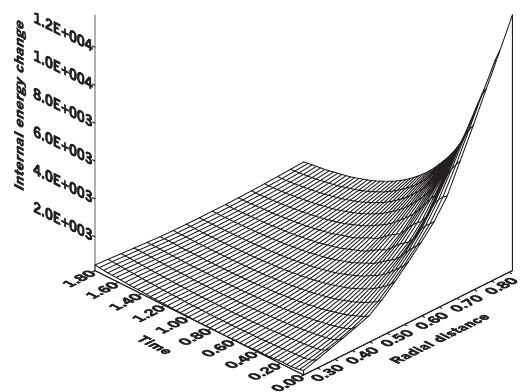
Figure 4.13 . Variation of the internal energy dU with radial dis- tance and